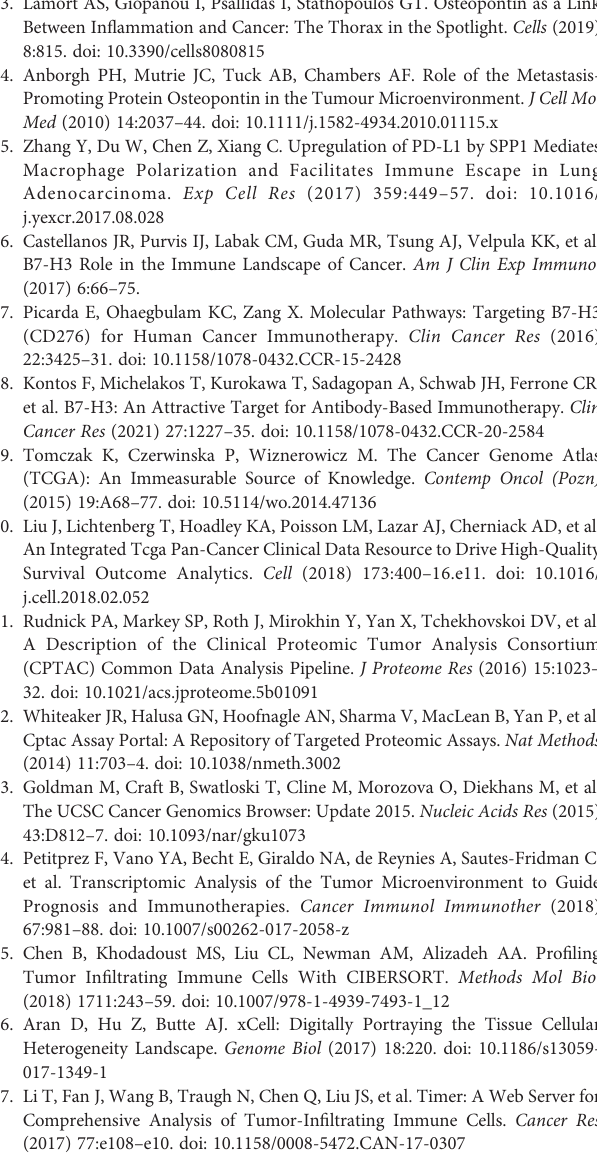
Supplementary Figure 1 | Effects of EGFR mutation and wild-type on prognosis of LUAD in different SPP1 expression groups in TCGA database. (A) Prognosis